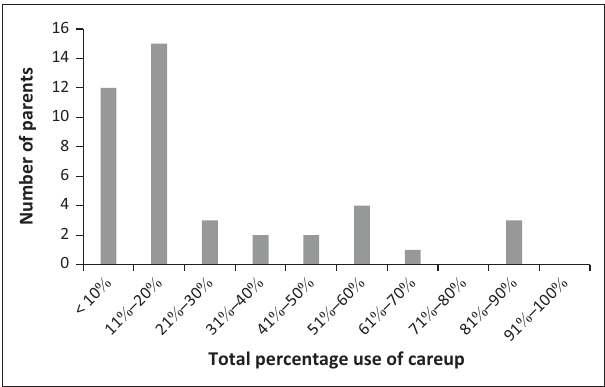
FIGURE 1: Percentage of parents’ active days CareUp usage ( n =